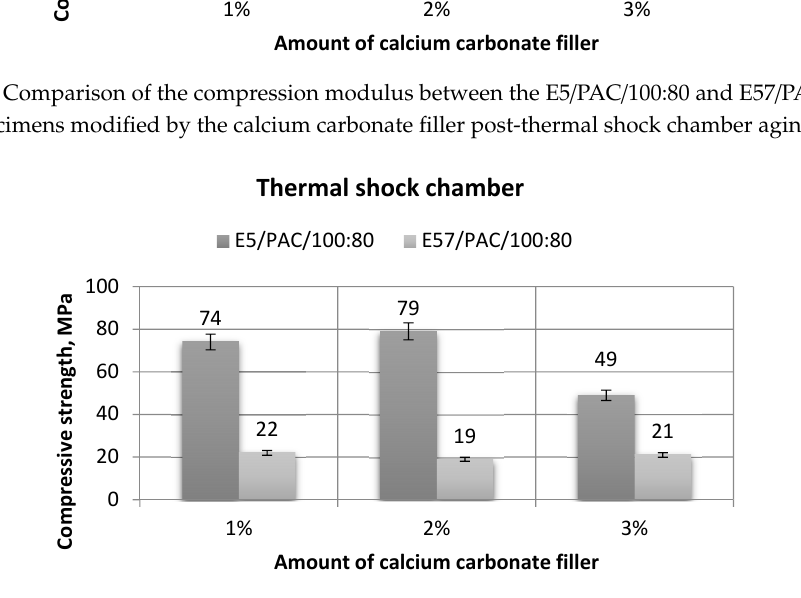
Figure 20. Comparison of the compressive strength between the E5/PAC/100:80 and E57/PAC/100:80 epoxy specimens modified by the calcium carbonate filler post-thermal shock chamber aging.